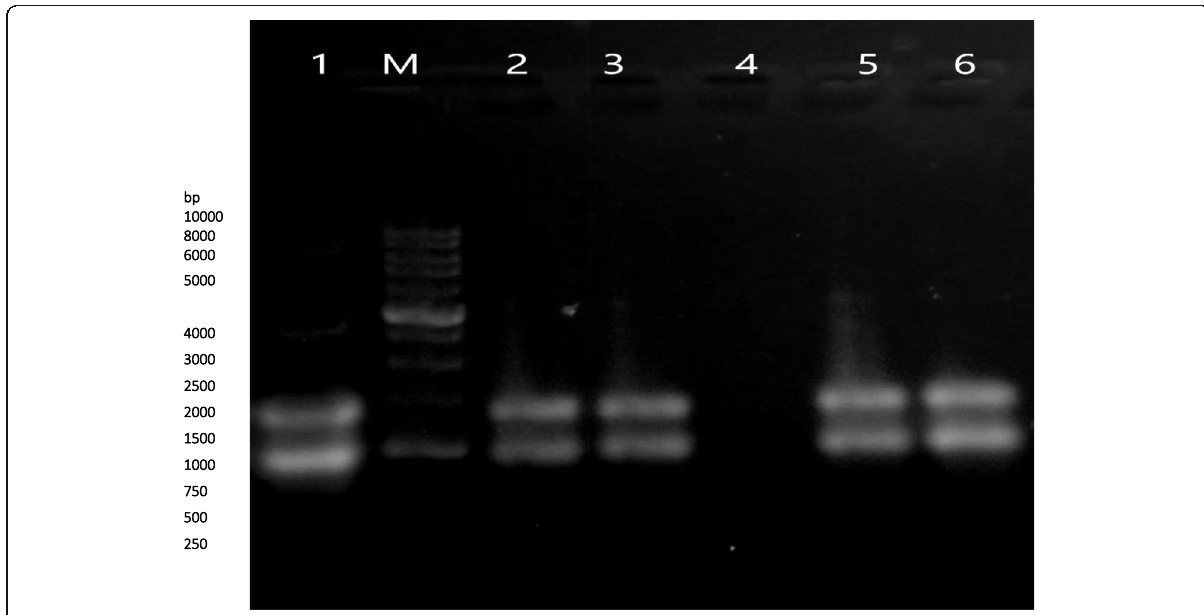
Fig. 5 Agarose gel electrophoresis for plasmid DNA purified from recombinant clones of E. coli DH5 α . Lane 1 pUCP24 vector; M 1kbp DNA ladder; lanes 2, 3, 5, and 6 recombinant plasmid (pUCP24- OmpH ) for strains 3, 4, 6, and 7 respectively; and lane 4 negative